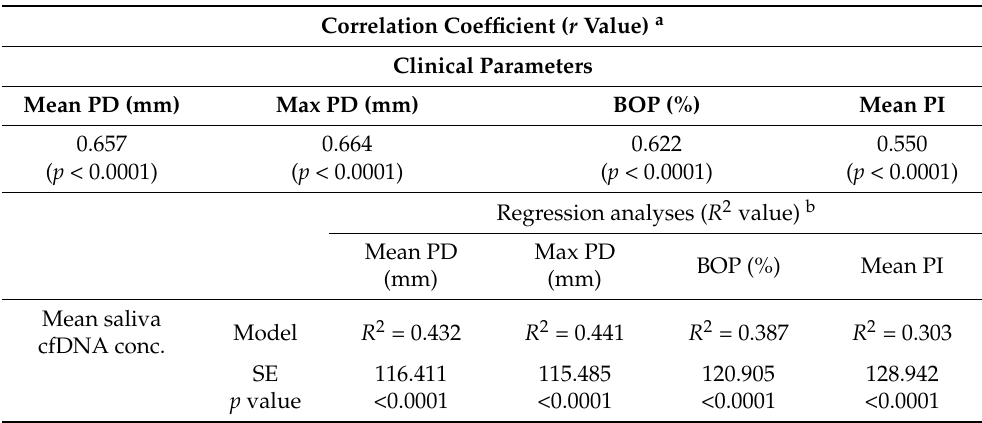
Table 3. Correlations between saliva cfDNA concentration and clinical